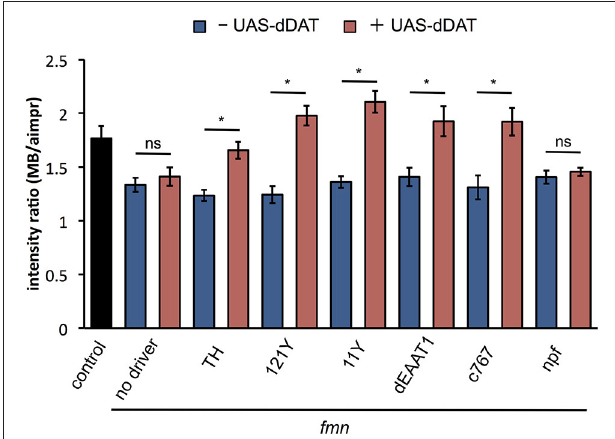
FIGURE 5 | dDAT expression rescues dDA1 down-regulation in the fmn mutant . dDA1 expression in the mushroom body was calculated as shown in Figure 4B . Error bars represent s.e.m. * P < 0.05; two-sided Student’s t